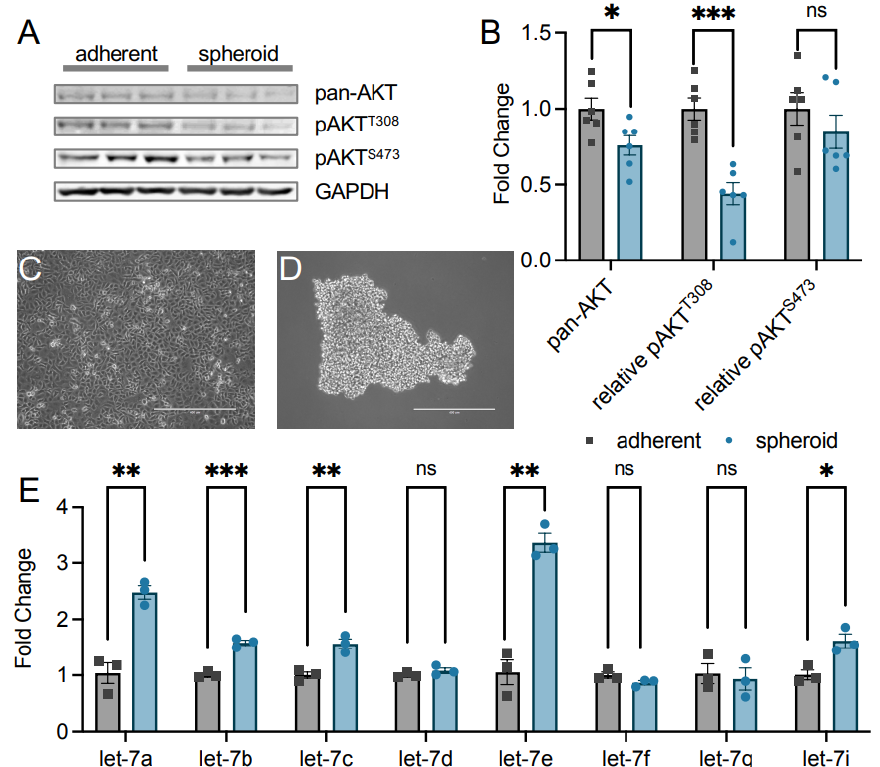
Figure 2. AKT phosphorylation and let-7 miRNA levels are inversely correlated in epithelial ovarian cancer metastasis. ( A ) Western blots of pan-AKT and pAKT protein levels were ( B ) quantified from adherent (grey squares) and spheroid (blue circles) TOV-21G ovarian cancer cells. Representative images of TOV-21G epithelial ovarian cancer (EOC) cells grown as ( C ) adherent and ( D ) spheroid cultures for 72 h. Scale bars indicate 400 nm. ( E ) RT-qPCR of let-7 family miRNAs in adherent (grey squares) and spheroid (blue circles) TOV-21G EOC cells. The data include n = 3 or n = 6 biological replicates. Error bars show ± 1 SEM. Asterisks indicate significance (ns, not significant; * p < 0.05; ** p < 0.01, *** p < 0.001).